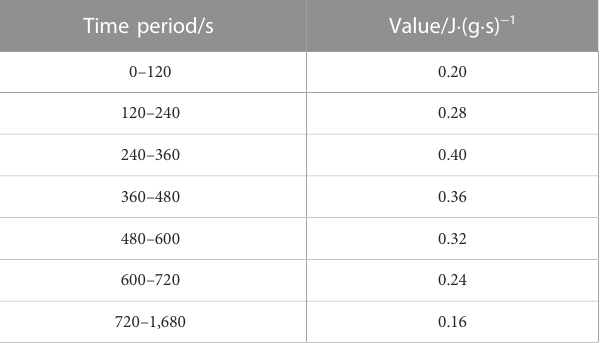
TABLE 1 Segmented values of the cement hydration exothermic rate during simulation. Time